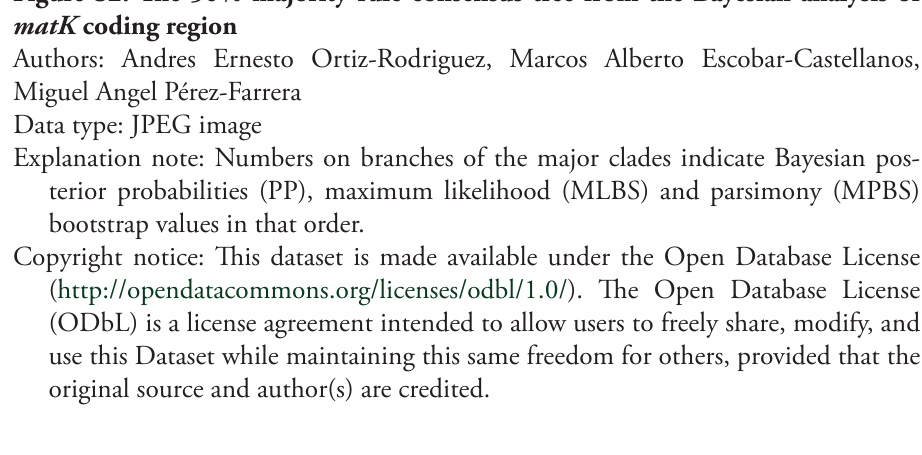
Figure S2. The 50% majority-rule consensus tree from the Bayesian analysis of matK coding